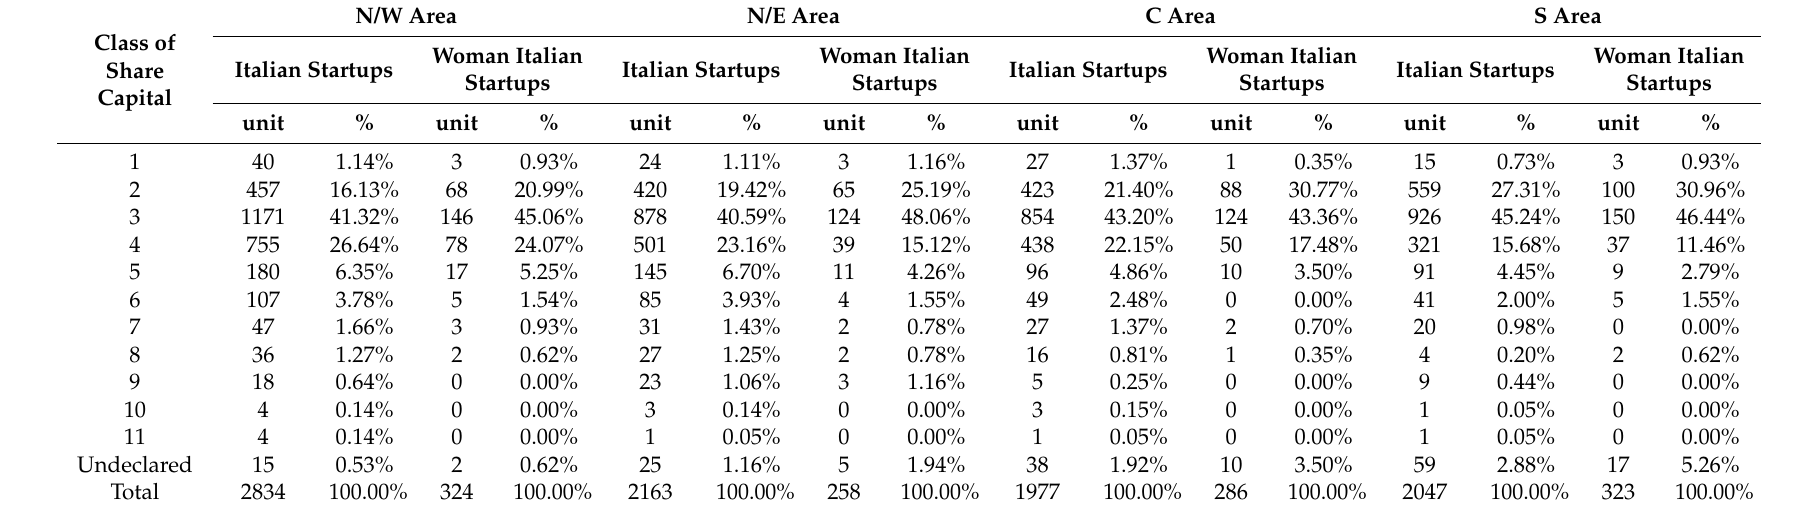
Table 4. Class of Italian startups and Italian woman startups’ share capital for geographical